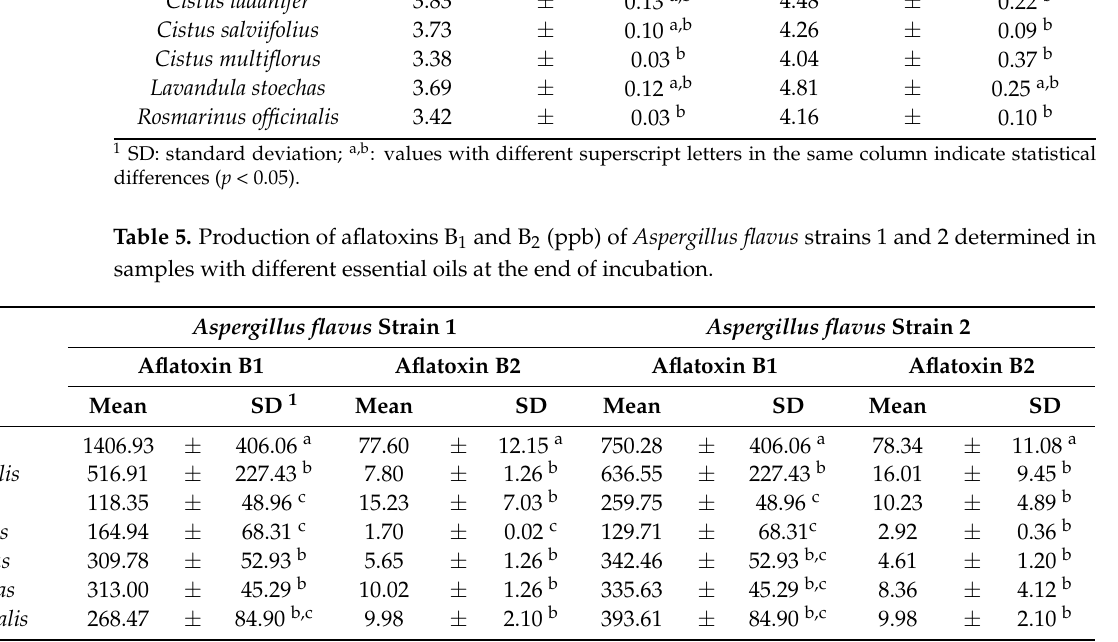
Table 4. Growth rate (mm/day) of A. flavus strains 1 and 2 that produce aflatoxins B ₁ and B ₂ obtained over 10 days of incubation at 25 °C.